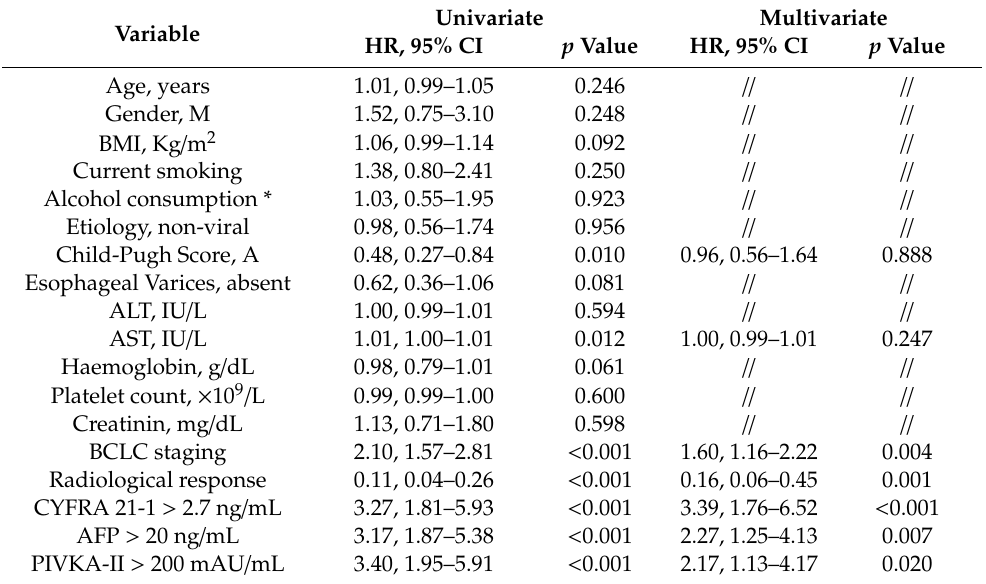
Table 2. Univariate and multivariate Cox proportional-hazard regression analysis of the predictors of overall survival.